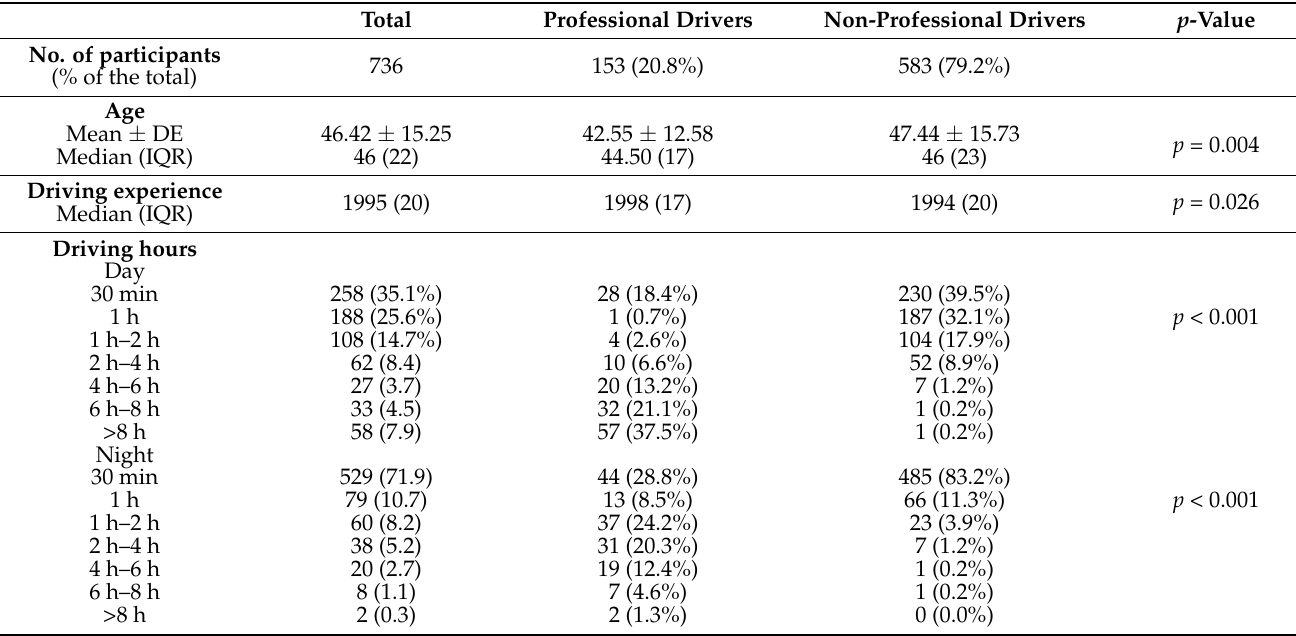
Table 1. Demographic data from the study